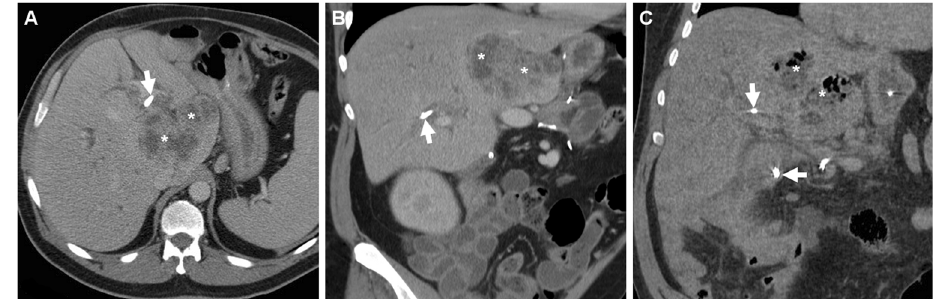
Fig. 10 Liver abscess in a 55-year-old man following PD performed at another hospital and complicated by sepsis. CT ( a , b ) showed development of a multilocular mass with peripheral and septal